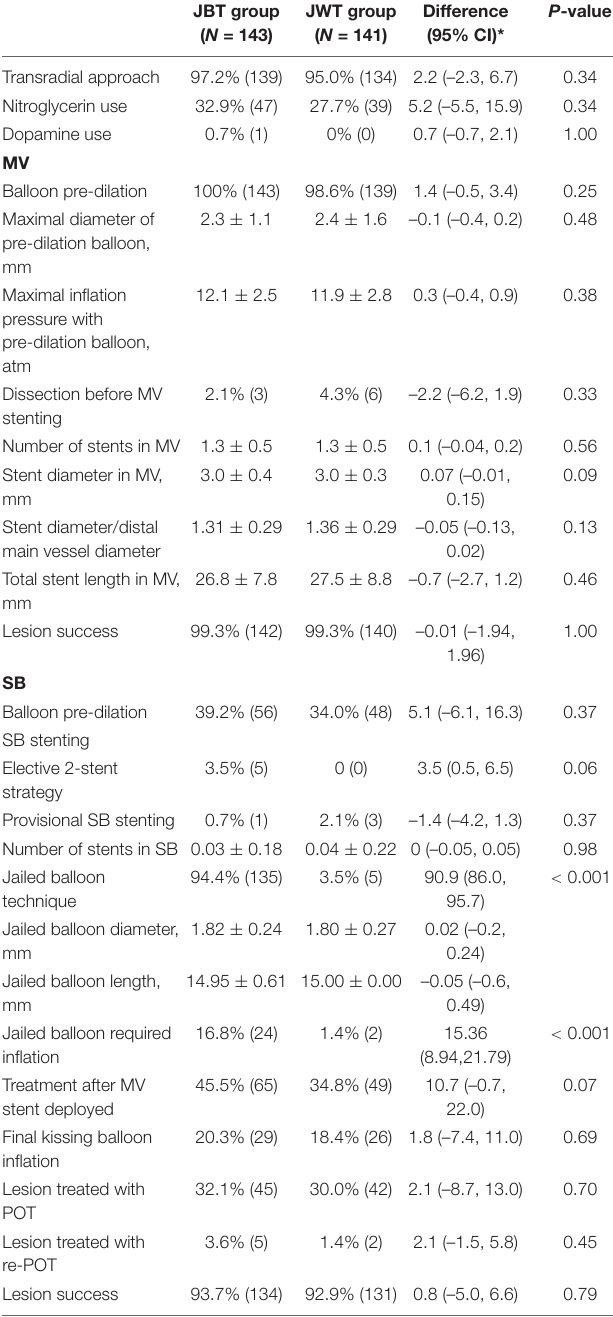
TABLE 3 | Procedural characteristics and results (intention-to-treat population).